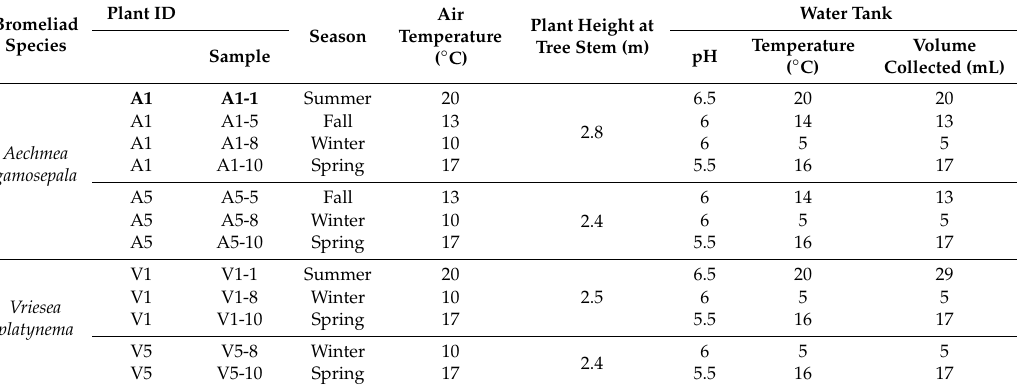
Table 1. Field data from the sampled bromeliads and their water